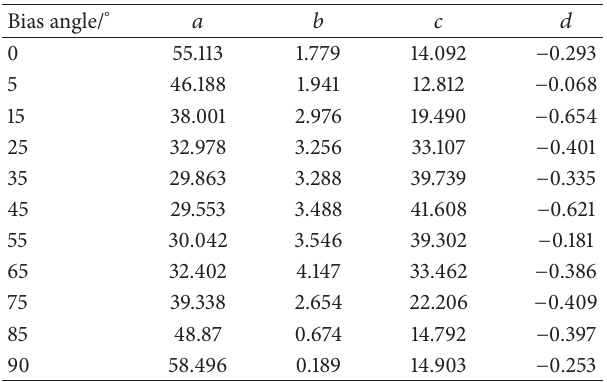
Table 3: Relationship between tensile strength & strain at break and tensile